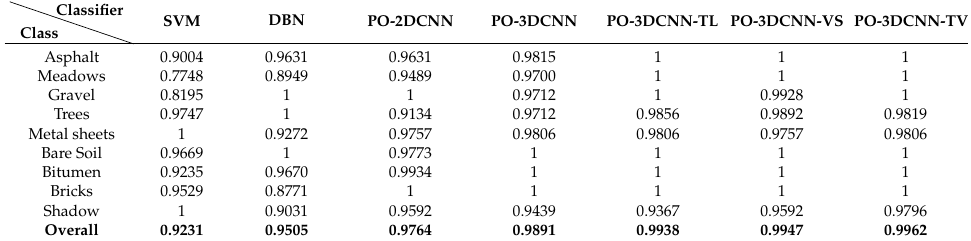
Table 5. OA values of nine classes in the part-PaviaU HSI vs. different classification models.